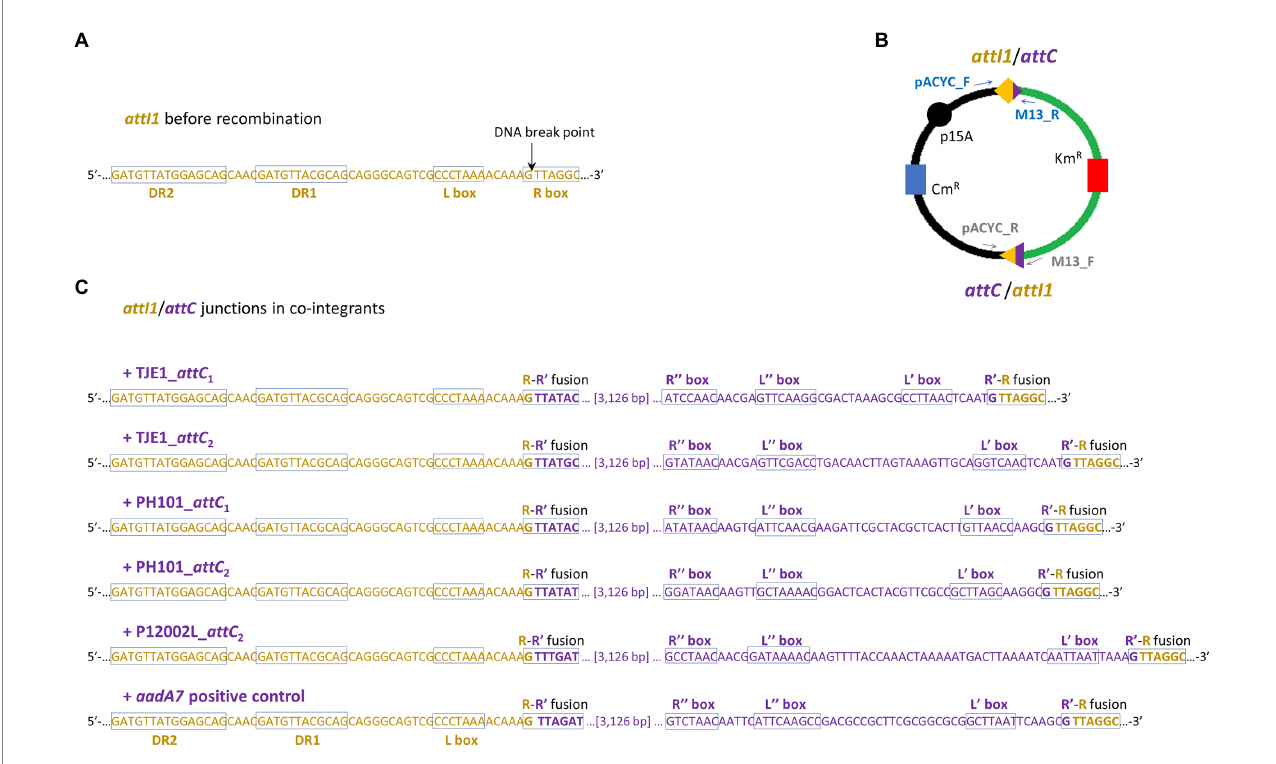
FIGURE 4 Two attI1 / attC junctions per co-integrant plasmid were formed between the attI1 -bearing recipient plasmid and the attC -donor plasmids. (A) DNA sequence of the attI1 site in the UB5201 recipient strain with L and R boxes (core IntI1 binding sites) and direct repeats DR1 and DR2. DNA cleavage occurs at the insertion points indicated by the black arrows during attC x attI recombination. (B) Schematic of the two recombination junctions in co-integrant plasmids following attC x attI recombination assay. The two pairs of PCR primers used to verify the two recombination junctions are shown as blue and grey arrows (schematic not drawn to scale). (C) DNA sequences at attC / attI junctions in co-integrant plasmids following attI1 recombination with five virulent phage-borne attC sites and the bacterial attC aadA7 positive control. The nucleotide bases belonging to attI1 and attC are shown in dark orange and purple, respectively. The recombined R-R’ boxes at the two attC / attI junctions are shown in the rectangles. The inverted repeats of the respective attC sites (L’, L,” R’, and R”) are all annotated according to HattCI predictions (Pereira et al.,